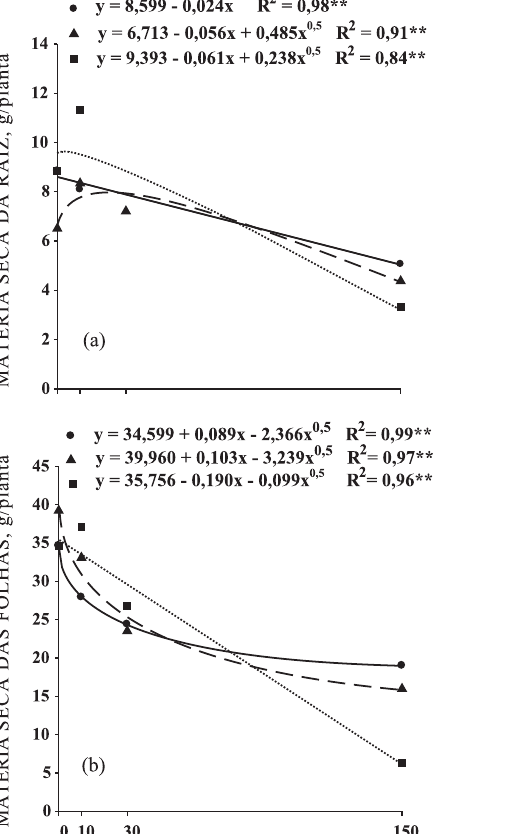
obtidos seria uma maior alocação de nutrientes e fotoassimilados para as raízes do que para as folhas.